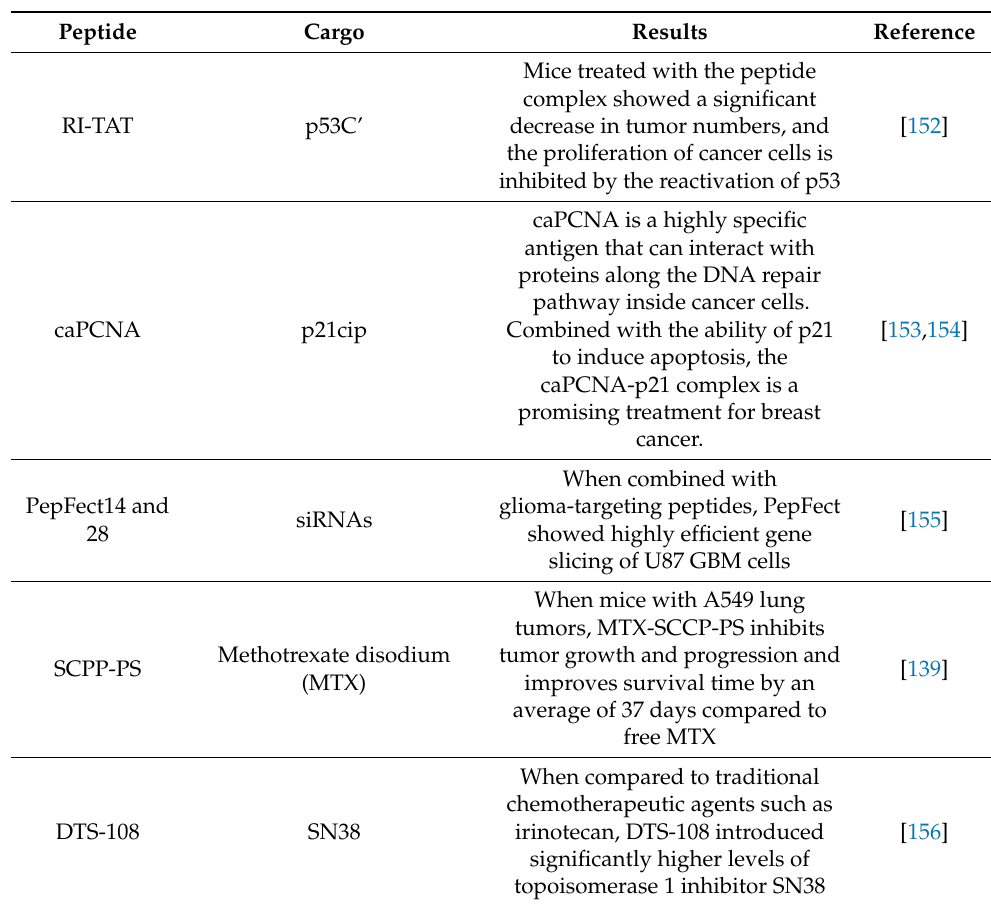
Table 2. Cont. Peptide